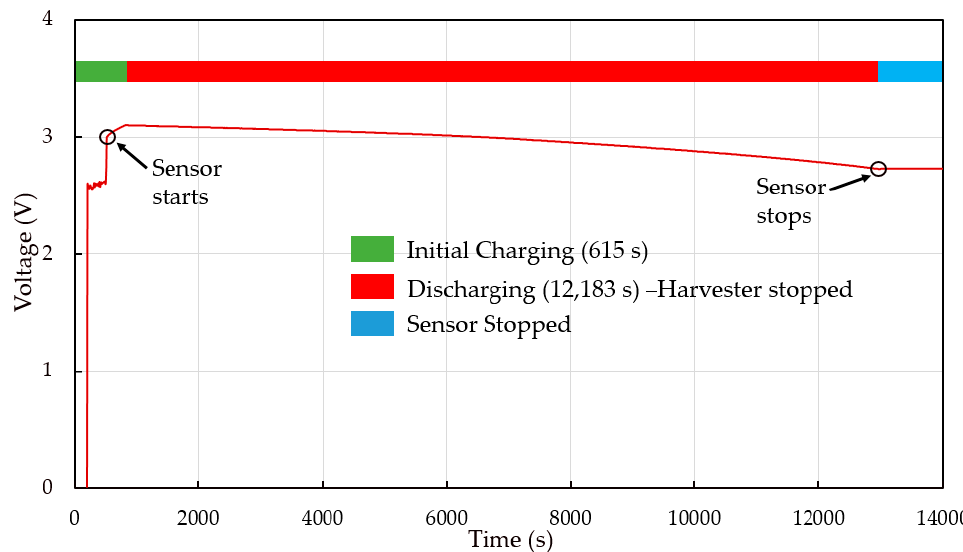
Figure 10. ( a ) Schematic of the system-level demonstration of the EMWEH, ( b ) conceptual illustra- tion of real-time environmental monitoring of an agricultural field using smartphone, and ( c ) pho- tograph of the experimental setup for remote environmental monitoring.